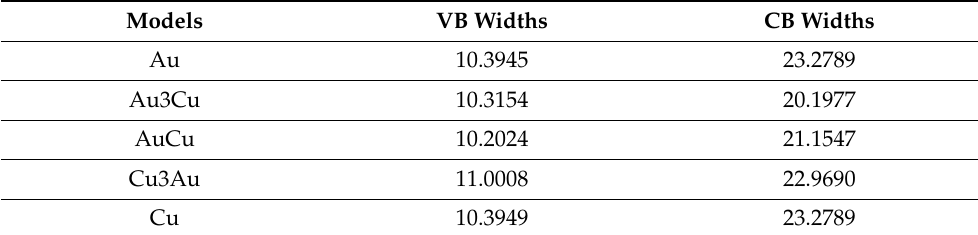
Table 3. Widths of VB and CB for different Au-Cu alloys models.